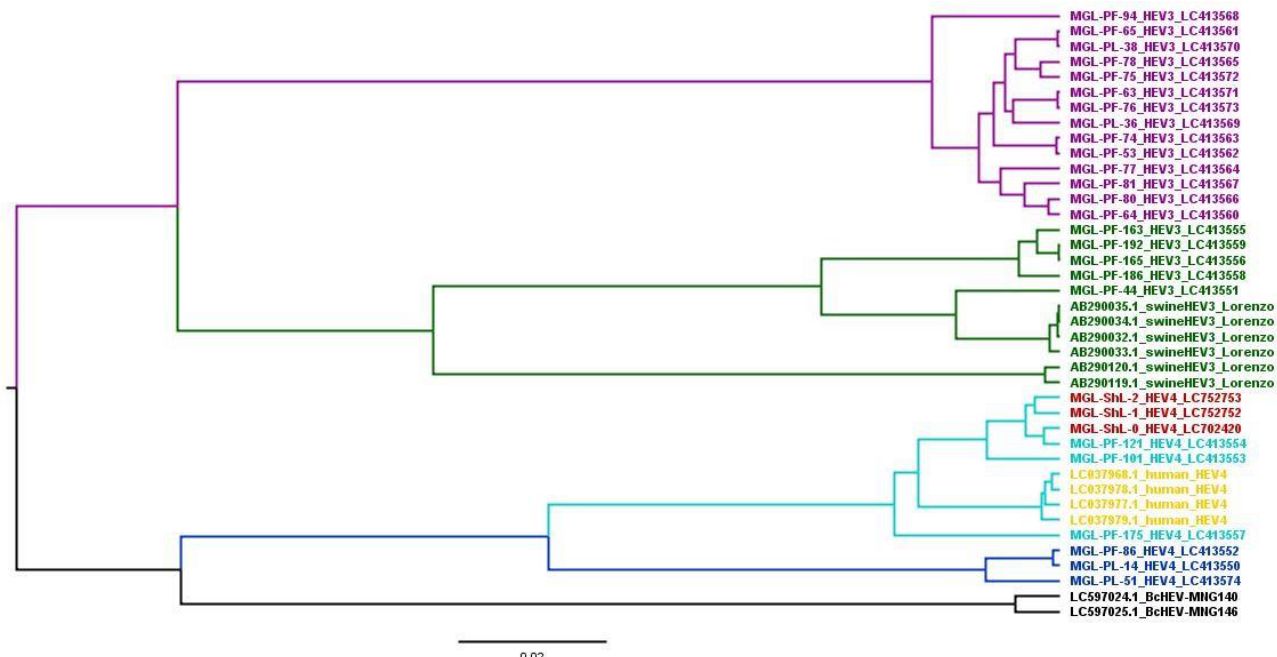
Figure 3. The Bayesian maximum clade credibility (MCC) host discrete traits tree for 302 bp HEV ORF2 nucleotide sequences (nt position 6022 – 6324) of 40 Mongolian strains, including 28 sequences from our study and reference strains (six swine HEV-ORF2 genotype 3, reprinted with permission from reference [16], four human HEV-ORF2 sequences [19], and two Bactrian camels HEV-ORF2 (BcHEV1, BcHEV2) sequences [26]) obtained from the GenBank database. The phylogenetic host tree indicated transmission between HEV hosts, the host at the node indicated the ancestor of the sub-group, and the number at the node indicated the posterior probability. The bar at the bottom of the figure denotes evolutionary distance .